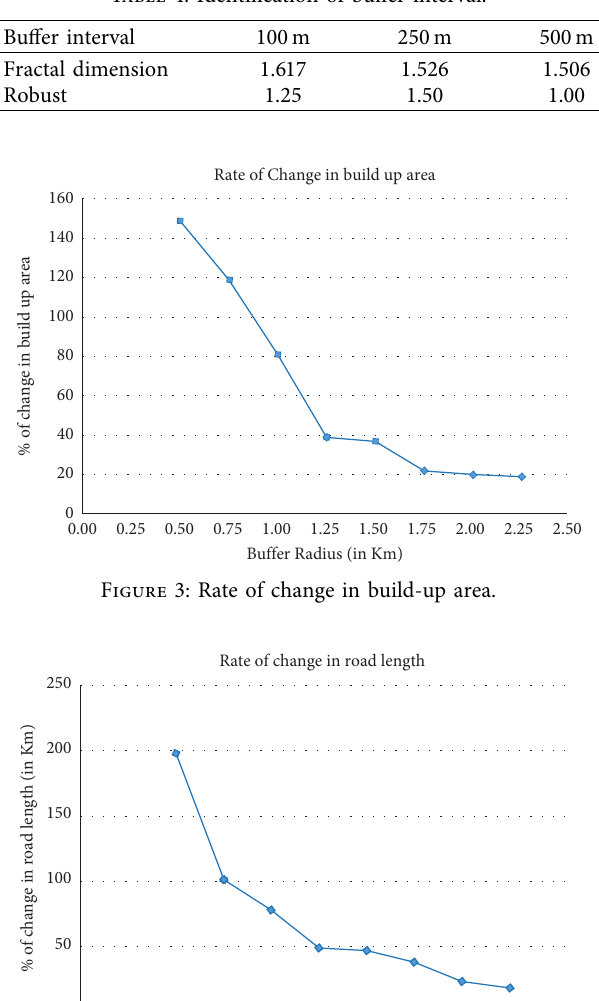
Table 4: Identifcation of bufer interval.